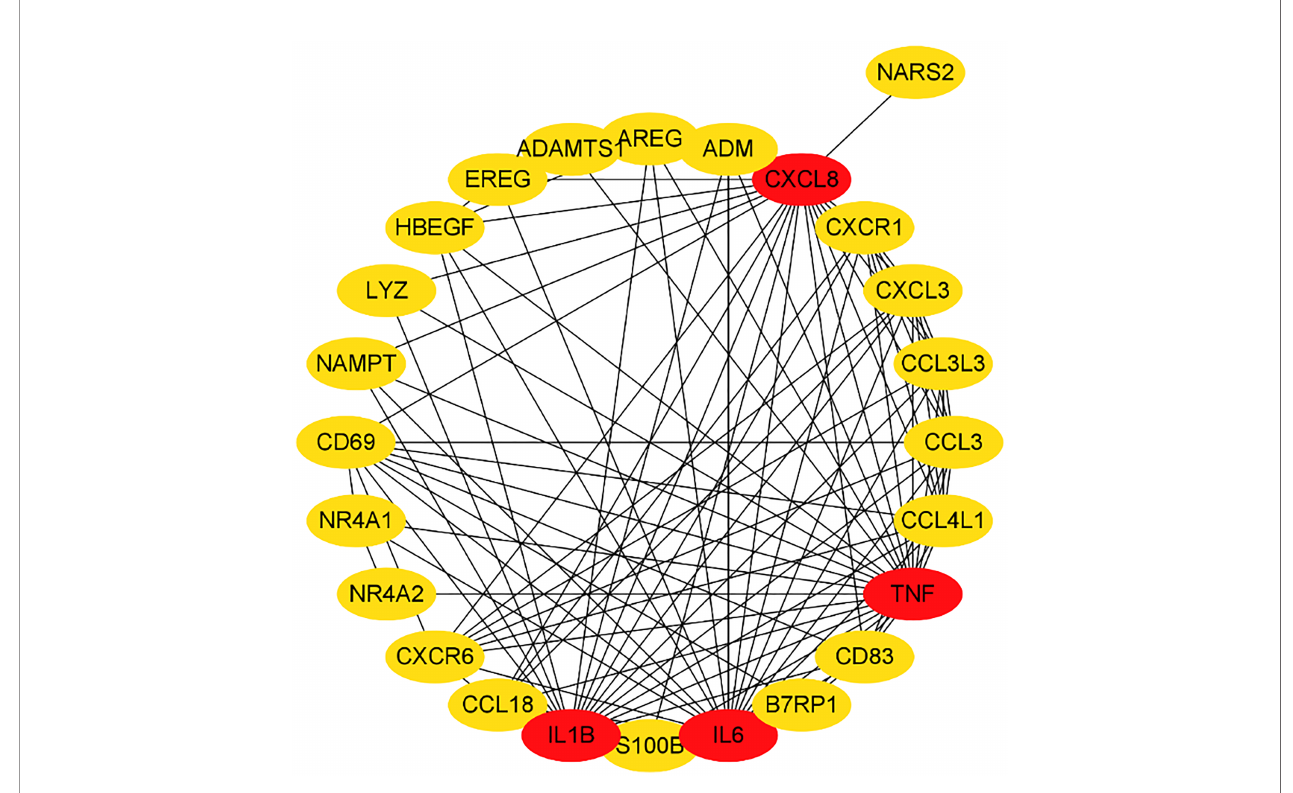
FIGURE 7 | Hub genes in the PPI network by EC.